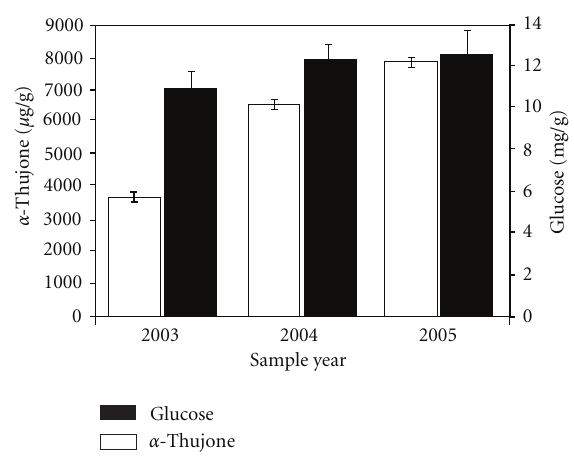
Figure 4: Foliar α -thujone and glucose concentrations of western redcedar seedlings subjected to soil and topical treatments. Bars represent one standard error of mean.